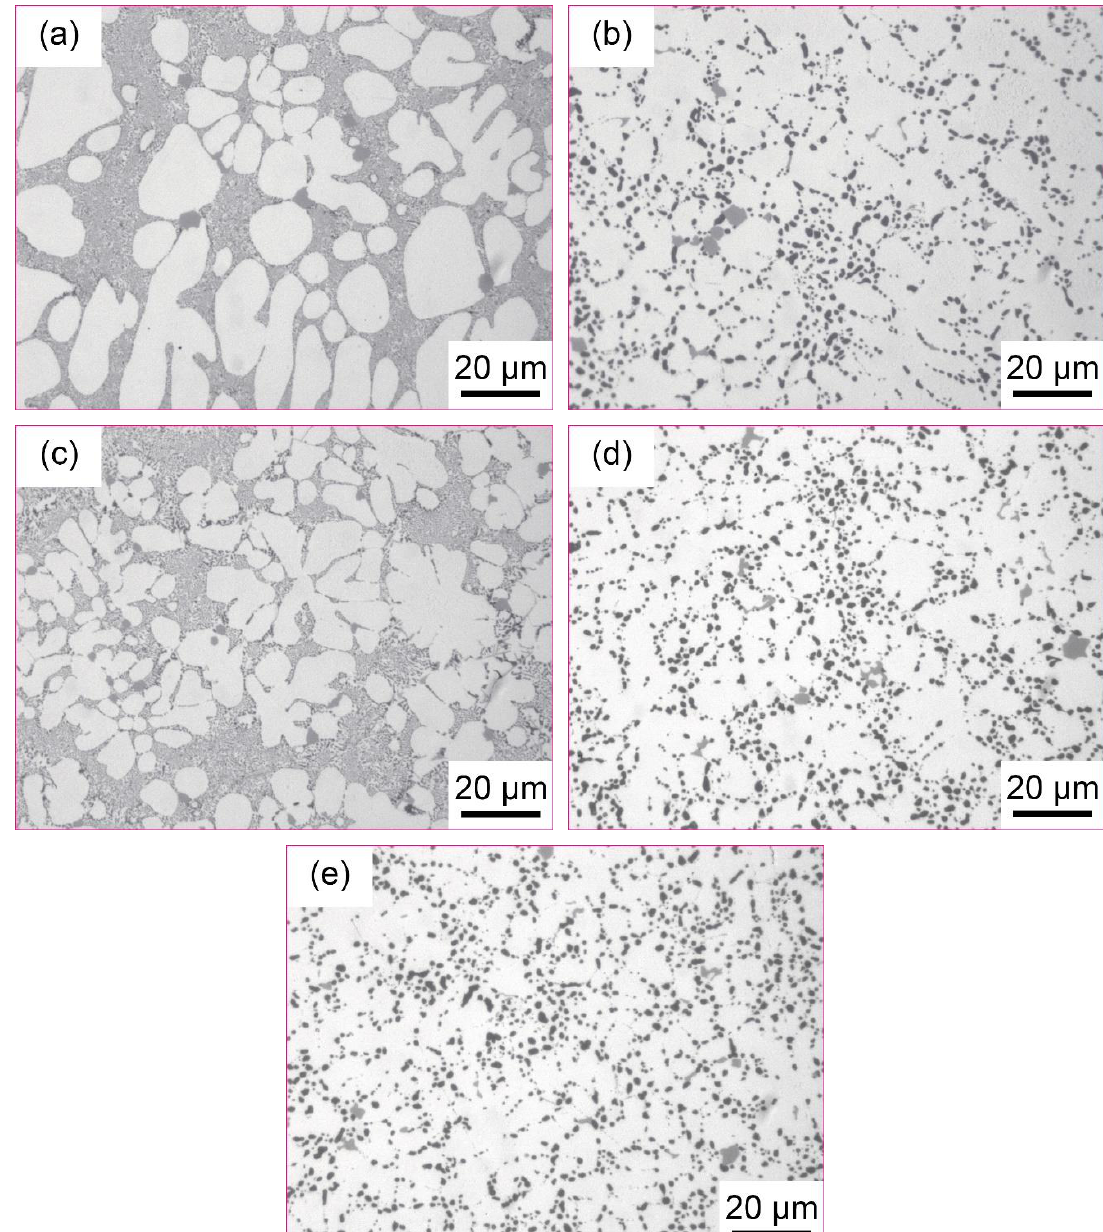
Figure 3. Microstructures of the AlSi10Mg0.3Mn alloy subjected different treatments: ( a ) F; ( b ) SHT; ( c ) T5; ( d ) T6; and ( e ) T7.